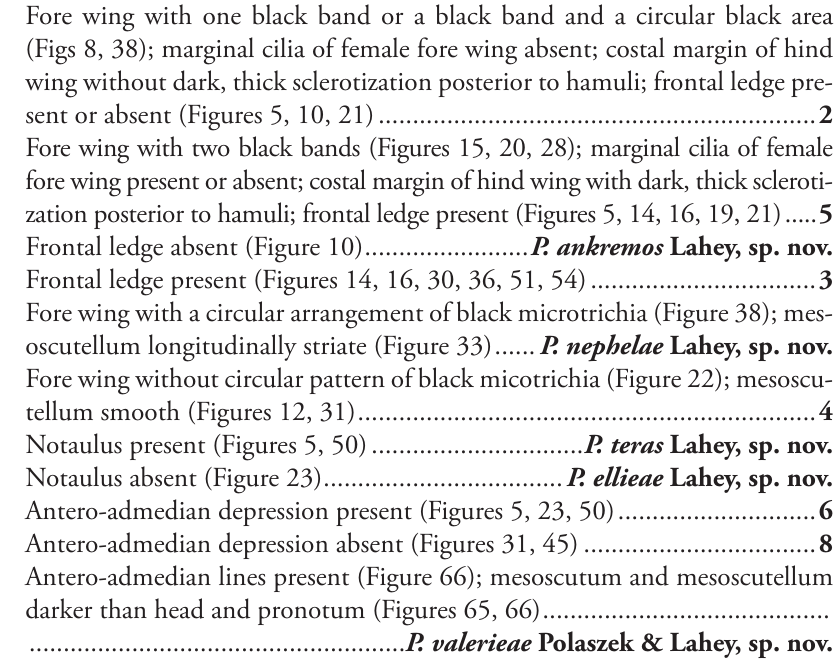
– Antero-admedian depression absent (Figures 31, 45) .................................. 8 6 Antero-admedian lines present (Figure 66); mesoscutum and mesoscutellum darker than head and pronotum (Figures 65, 66) .......................................... ....................................................... P. valerieae Polaszek & Lahey, sp. nov. – Antero-admedian lines absent; pronotum, mesoscutum and mesoscutellum concolorous and lighter than head and metasoma (Figures 12, 31) .............